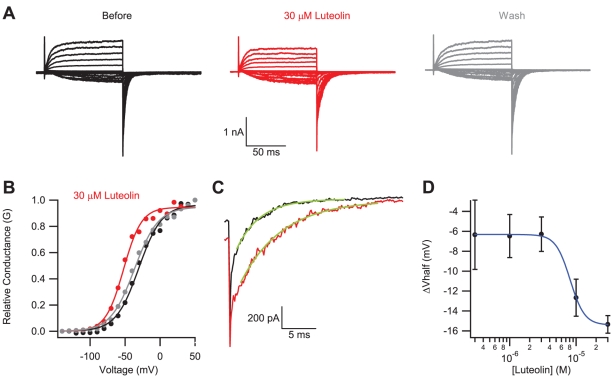
Luteolin modulated currents from EAG1 channels.Current traces (A) and conductance-voltage relationship (B) for EAG1 channels recorded in the inside-out patch configuration in the absence (black), presence (red) and after washout (grey) of 30 µM luteolin. (C) The tail current recorded at −120 mV, following a voltage step to −50 mV, in the absence (black) and presence (red) of 30 µM luteolin, fit with single exponentials to give time constants of 3.5 ms before, and 6.2 ms after application of luteolin. (D) Plot of the change in the Vhalf versus luteolin concentration, fit with a Hill equation with a binding affinity of 9.1 µM, and a Hill coefficient of 4.